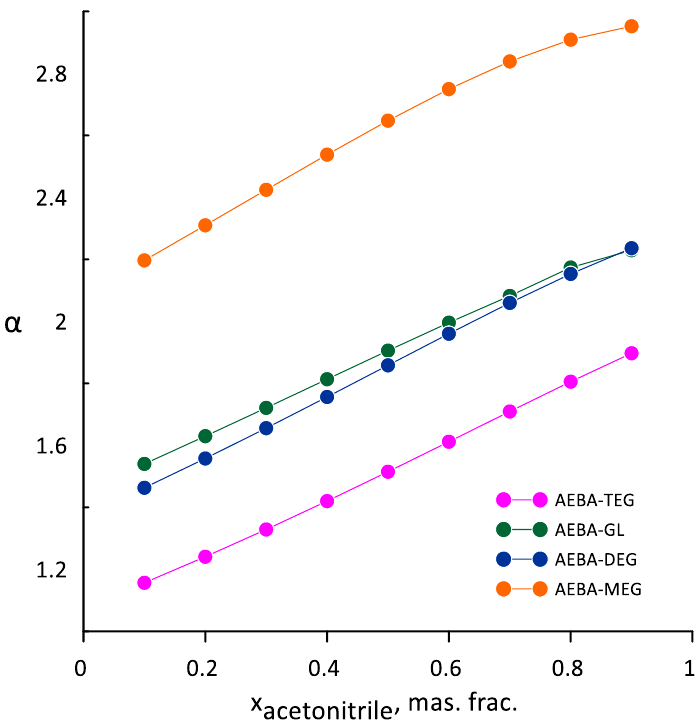
Figure 12. Relative volatility of acetonitrile in an azeotropic mixture of ethanol–acetonitrile with the addition of 60 wt.%